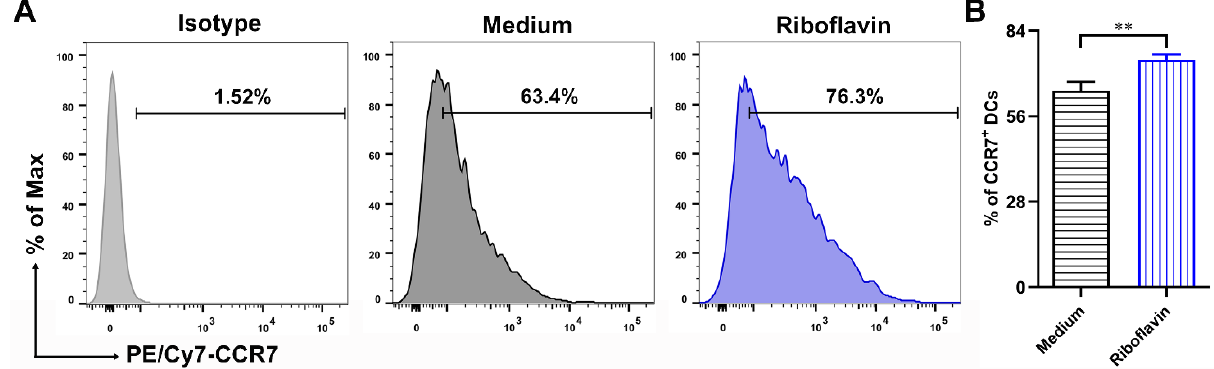
Figure 6. Riboflavin enhances the expression of CCR7 in DCs. DCs were incubated with riboflavin (40 μ M) for 24 h. ( A ) The expression of migration marker CCR7 was detected via FCM. ( B ) The percentage values are presented as the mean ± SD. Results are from one representative experiment out of three performed. Unpaired Student’s two-sided t -tests were employed to determine the differences between the two groups; ** p < 0.01.